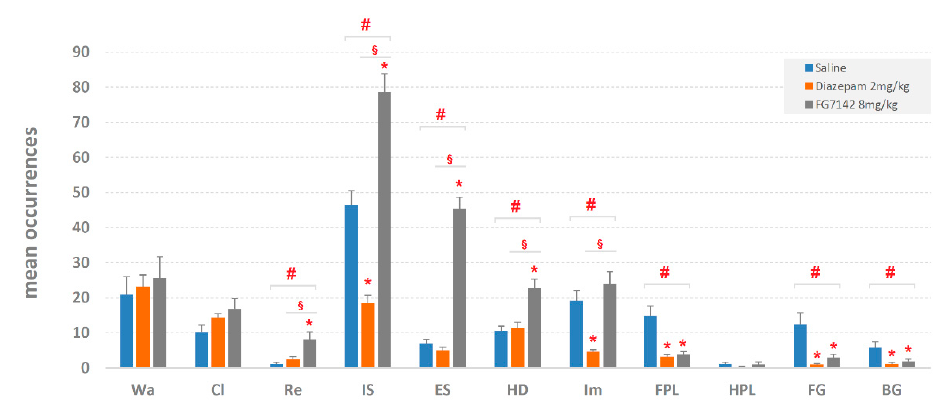
Figure 2. Mean occurrences ± SEM of each component of the behavioral repertoire (see Figure 1) in saline, diazepam 2 mg/kg and in FG7142 8 mg/kg groups. # = statistically significant ( p < 0.05) ANOVA result; * = significant ( p < 0.05) difference of diazepam or FG7142 groups in comparison with saline group (Newman–Keuls post-hoc test for multiple comparisons); § = significant ( p < 0.05) difference between diazepam and FG7142 groups (Newman–Keuls post-hoc test for multiple compar- isons). Data obtained from the analysis of three groups each encompassing 10 subjects. See Figure 1 for